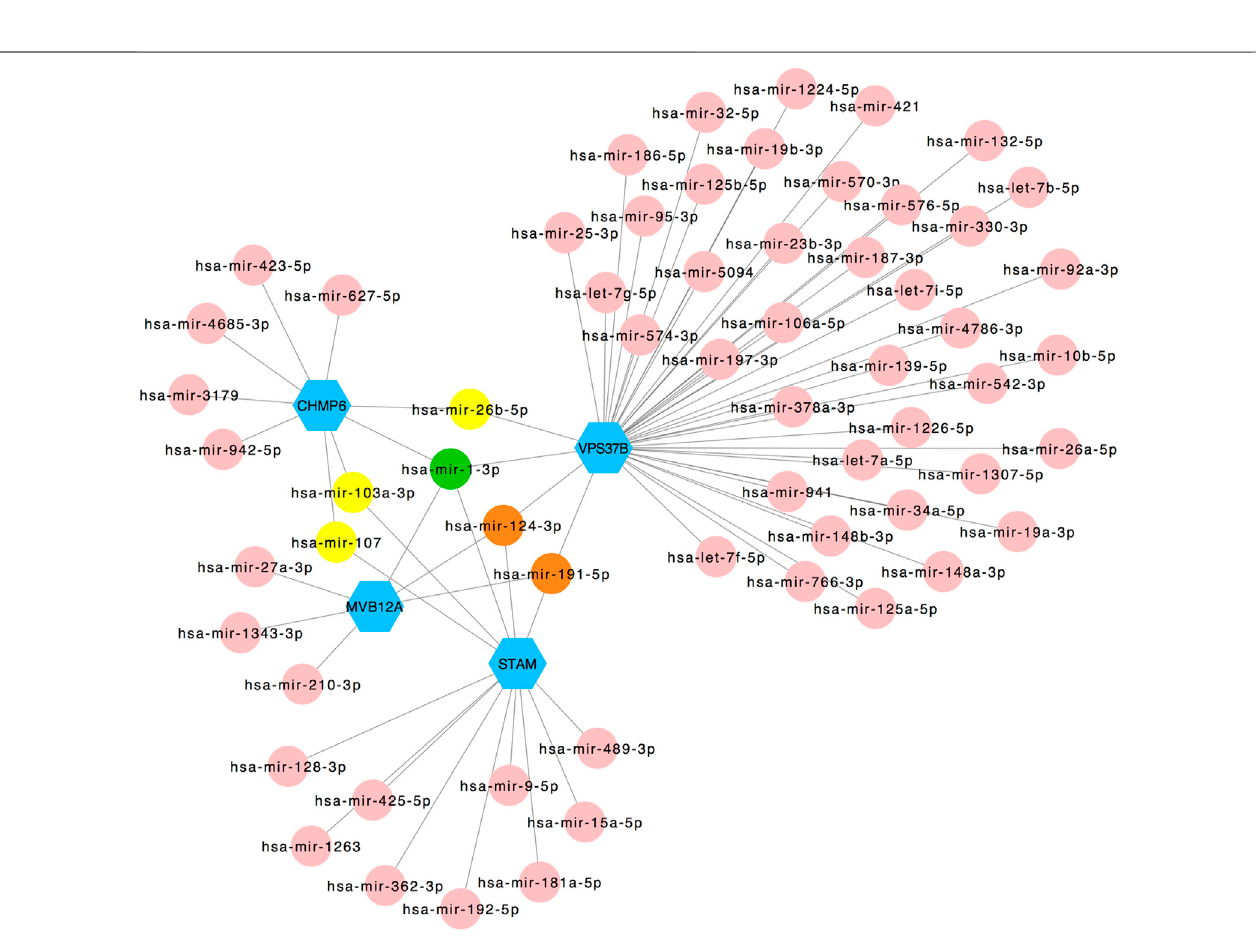
Frontiers in Genetics |